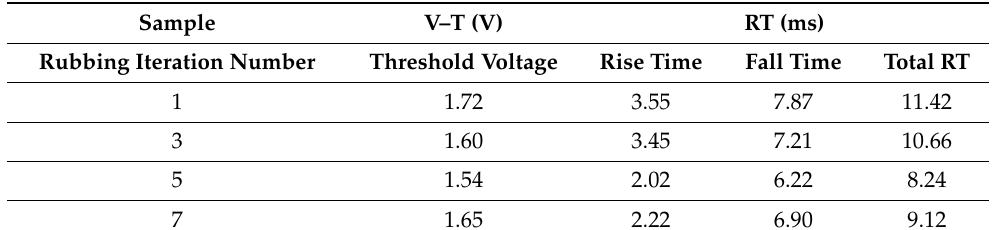
Table 1. Voltage–transmittance (V–T) and response time (RT) characteristics of TN LC cells with rubbed ZnO films as a function of rubbing iteration number.